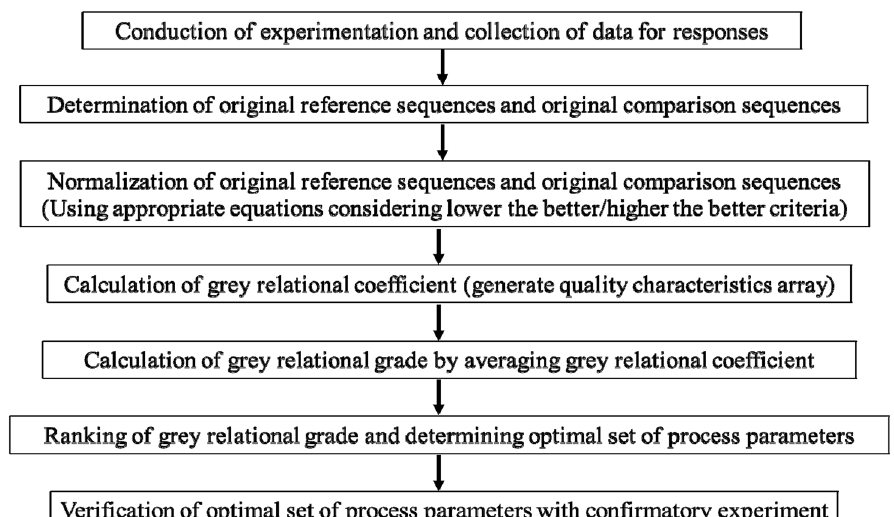
Fig. 2 Stepwise procedure for grey relational analysis